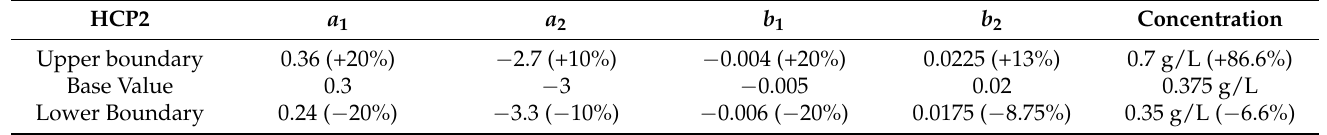
Table 3. HCP2 parameter boundaries for the dataset